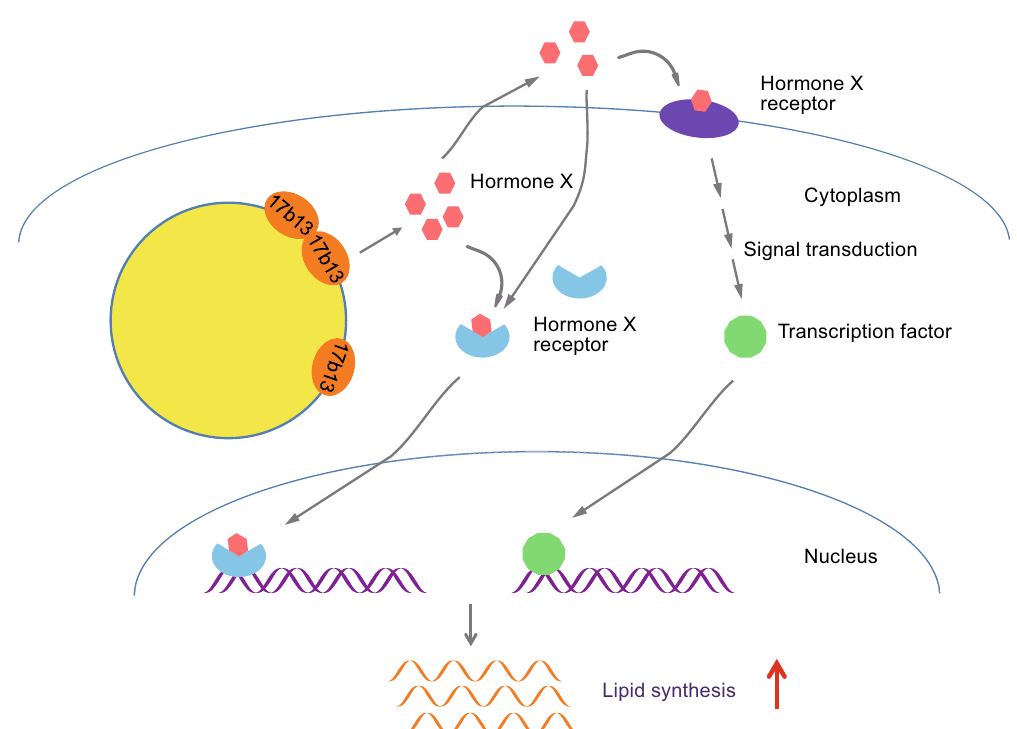
Figure 1. Hypothetical mechanism of 17 β -HSD13-mediated lipid accumulations. Increased 17 β -HSD13 on LDs produces hormone X that binds to a cytosolic receptor by intracrine regulation. The hormone X may also be secreted to extracellular space and bind to a membrane-bound receptor or crosses the plasma membrane and binds to a cytosolic receptor by autocrine or paracrine regulation. The cytosolic ligand-bound receptors thus enter the nucleus and bind to regulate elements. The activated membrane- bound receptors may transduce signals to promote transcription factors enter nucleus. Hence, the expression of genes related to lipid synthesis are eventually up-regulated leading to lipid accumulation and LD expansion in hepatic